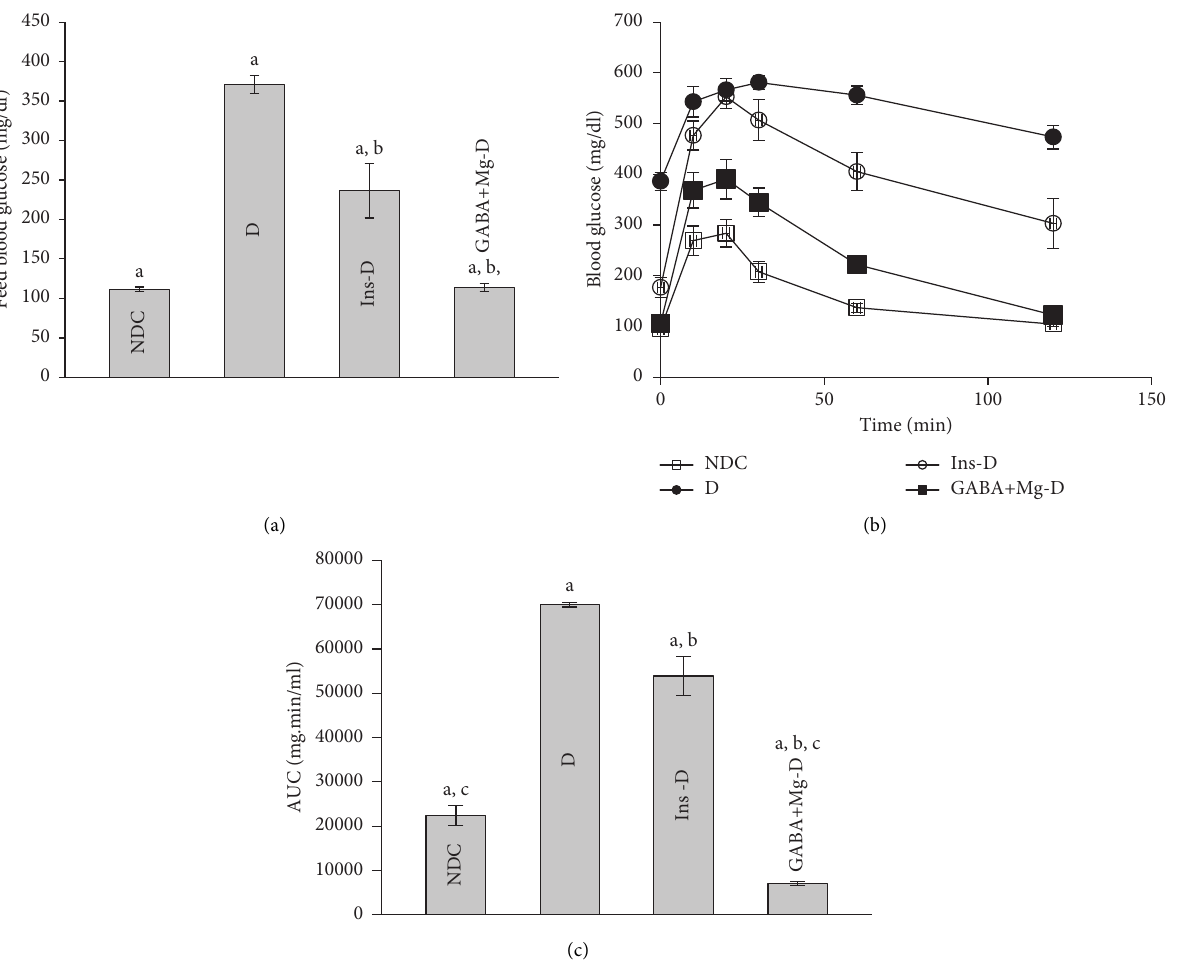
Figure 1: Comparison of feed blood glucose. (a) intraperitoneal glucose tolerance test (GTT) and (b) the area under the curve (AUC) of blood glucose 3 months after treatment. (c) In the control group (NDC-without diabetes) receiving a normal diet, the group with chronic diabetic were fed a high-fat diet along with 35mg/Kg STZ (d), diabetic animals receiving insulin treatment (2.5 U/Kg two times per day) (Ins-D), and animals with diabetes receiving GABA treatment (1.5gr/kg)+MgSO 4 (10 g/l add in drinking water) (GABA+ Mg-D) (each group has 10 rats. Data are presented as mean ± SEM). A significant difference between D and other groups ( P < 0.0001). b Significant difference between GABA+Mg-D and Ins-D group ( P < 0.001). c Significant difference between NDC group and GABA+Mg-D ( P <